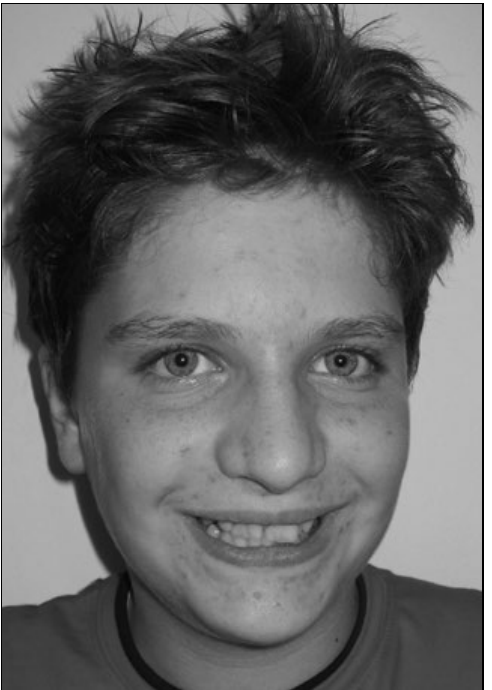
Figure 1. Initial frontal extra-oral photograph. Both upper central incisors had wide and bifid crowns.